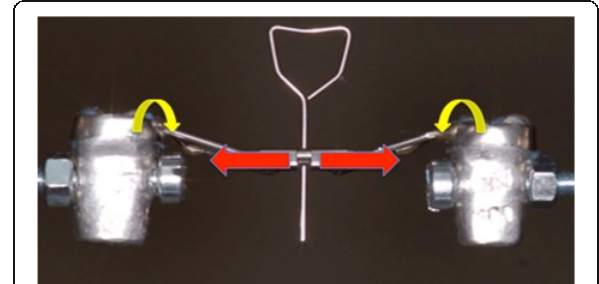
Fig. 11 Four-arm RPEs: bending moment generated on the horizontal